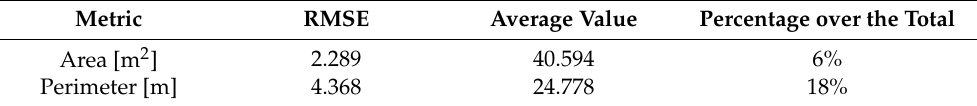
Table 7. Root mean square error of the area and perimeters of the house objects in the Niger study area.